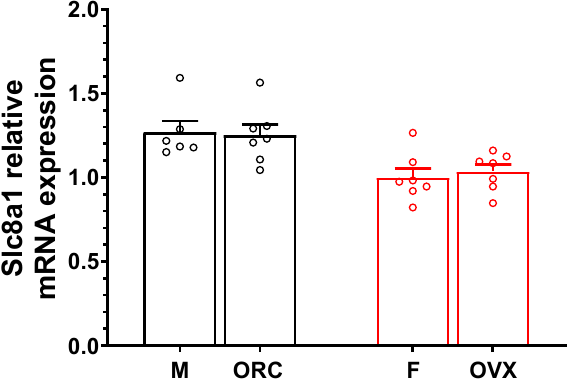
Figure 7. Atrial Slc8a1 gene expression is not affected by orchiectomy (ORC) and ovariectomy (OVX) in mice. Scatter plot shows no difference in the mRNA expression of Slc8a1 in ORC and OVX compared to their respective controls (N = 6–7/group).